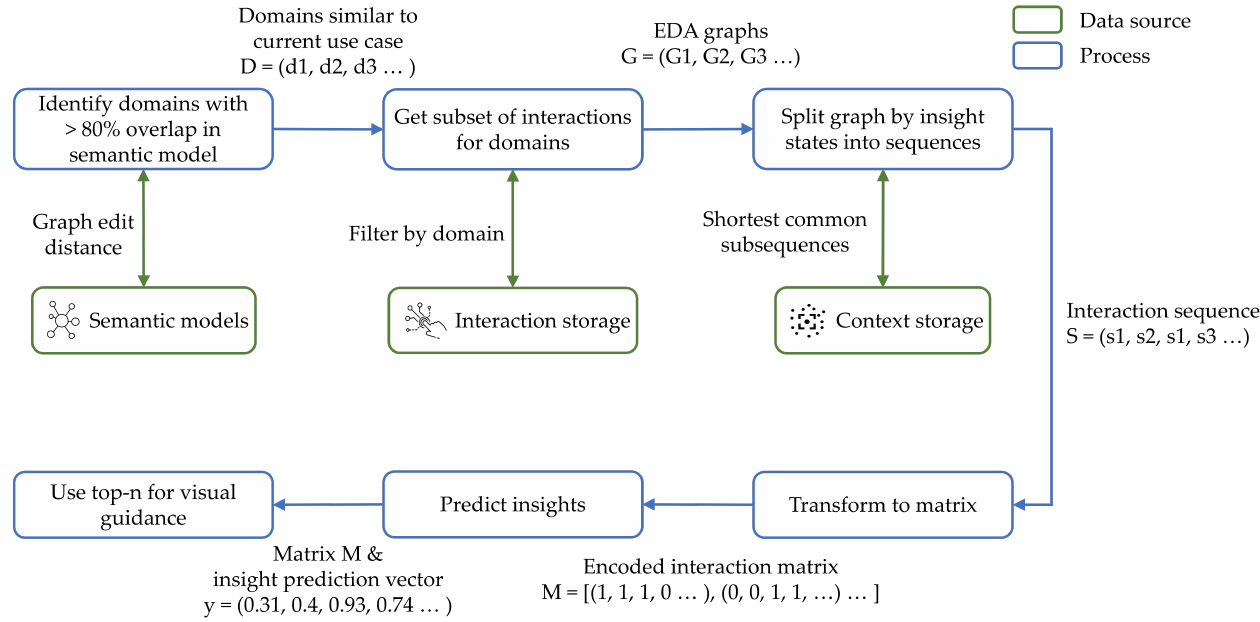
Figure 2. Process ( blue ) overview of the recommendation system and associated data sources (system components) ( green